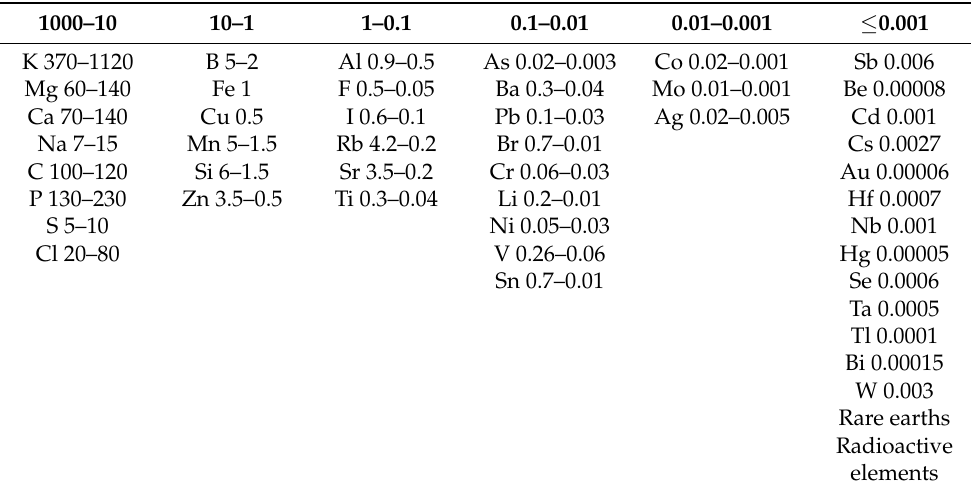
Table 2. Inorganic constituents [mg/L] of wine (typical values of normal contents)